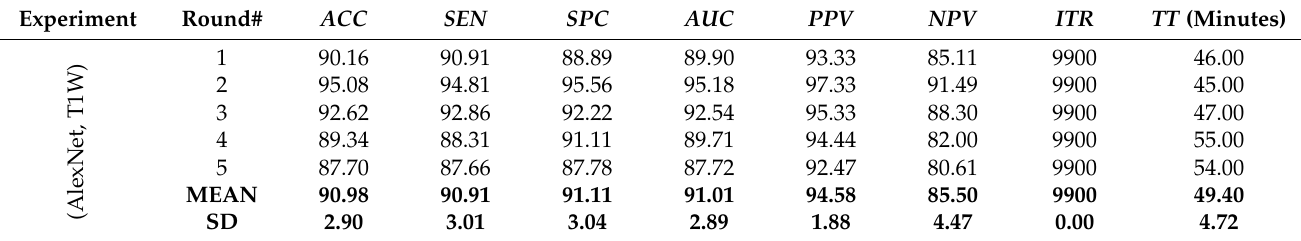
Table A3. Test results of five-folds of experiment (AlexNet, T1W).